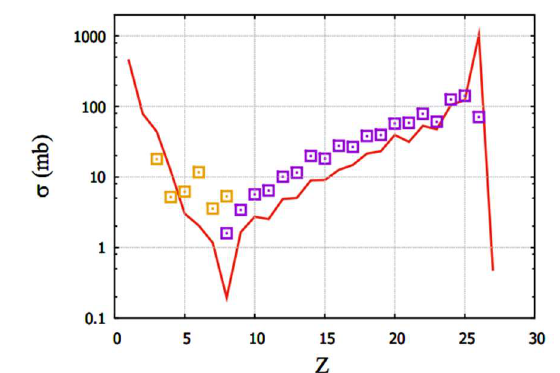
Figure 5. (Color online) Symbols show the experimental Z- distribution of spallation residues [4] and emitted IMFs [5] in 𝐹𝑒 (cid:2873)(cid:2874) + 𝑝 reactions at 1.0 GeV/A. The solid curve shows the calculated distribution with CoMD-MECO described in the